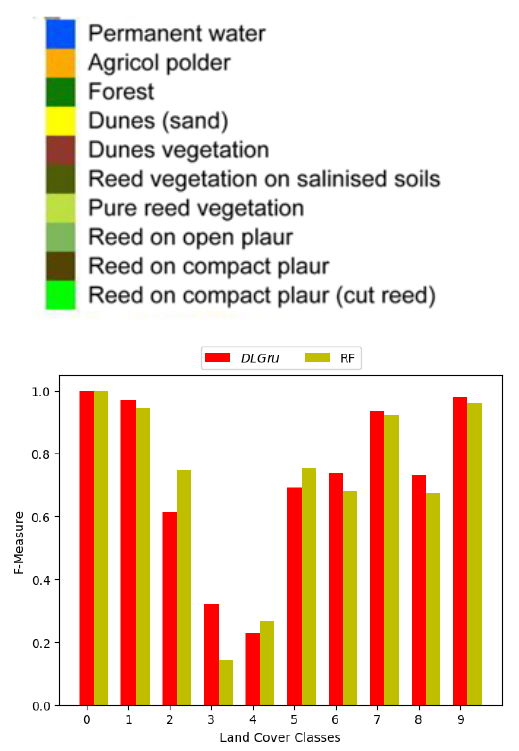
Figure 6: Performance of F-measure for the time series classification by class for Deep learning algorithm